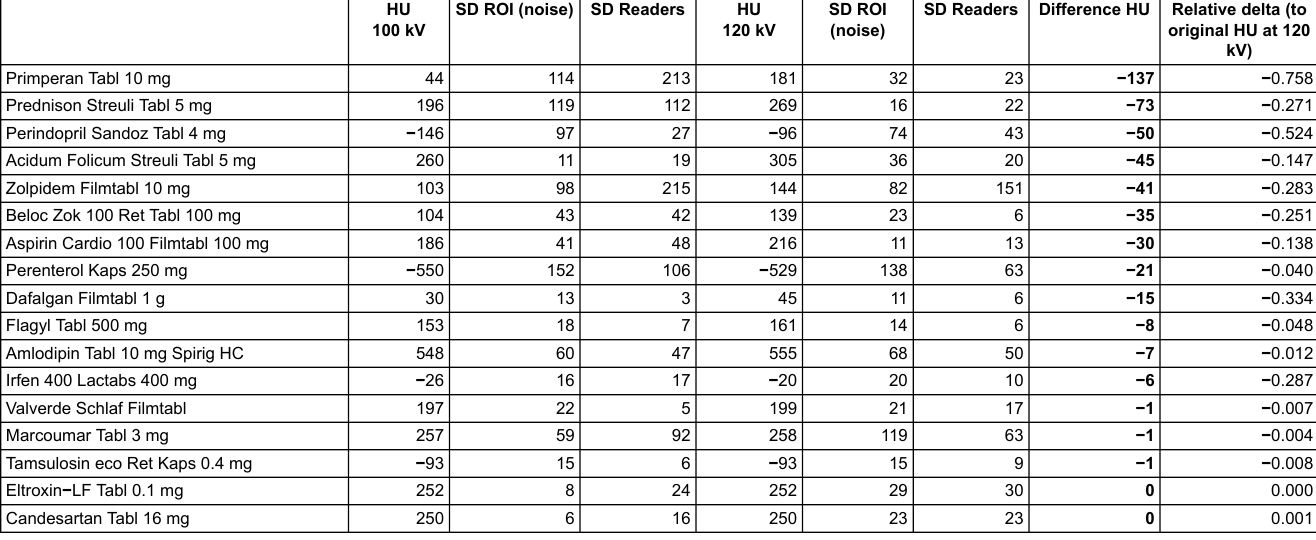
Table 2: Medicaments with negative delta (lower HU with lower kV [tube voltage]).